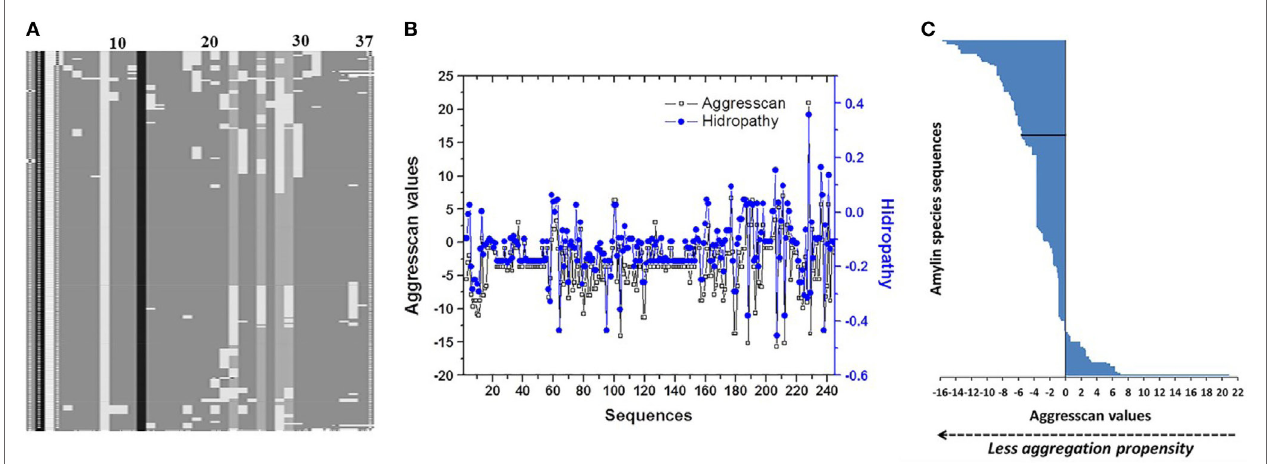
FigUre 1 | Analysis of primary structure of islet amyloid polypeptide (IAPP) among 240 species. (a) Evaluation of multiple alignments of 240 sequences showing the conserved sites (24). (B) Analysis of correlation among Aggrescan and hydropathy values of sequences. (c) Distribution of Aggrescan values throughout 240 sequences of IAPP. Negative values were associated with lower aggregation propensity, and positive values with higher aggregation propensity. In black line is identified the sequence of hIAPP. TaBle 1 | Primary structure of hIAPP placed in order position, showing the different variants that were originated from the comparison among 240 sequences, the frequency of each variant is shown. Position amino Variants residue variants Total of sequences with the acid specific variants